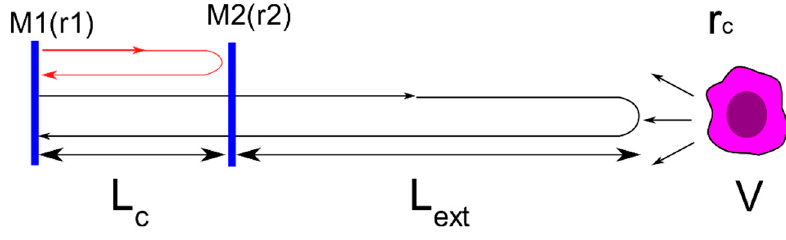
Figure 1. The schematic of three-mirror model.